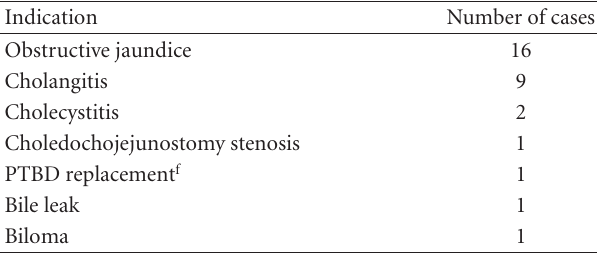
Table 1: Indications for EUS-guided interventions.